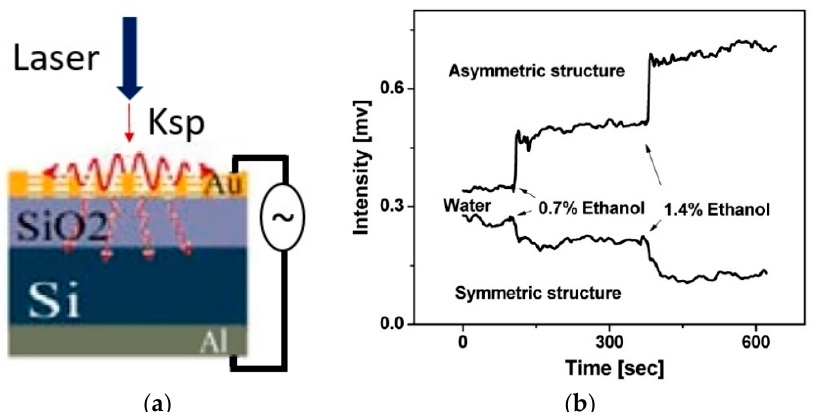
Figure 7. ( a ) Schematic of plasmonic nanostructures integrated with the silicon photodetector. ( b ) Output of the sensor showing measurements for symmetric and asymmetric plasmonic nanohole arrays when water and different concentrations of ethanol were applied. Reprinted with permission from [69]. Copyright © The Optical Society (OSA) (2011).